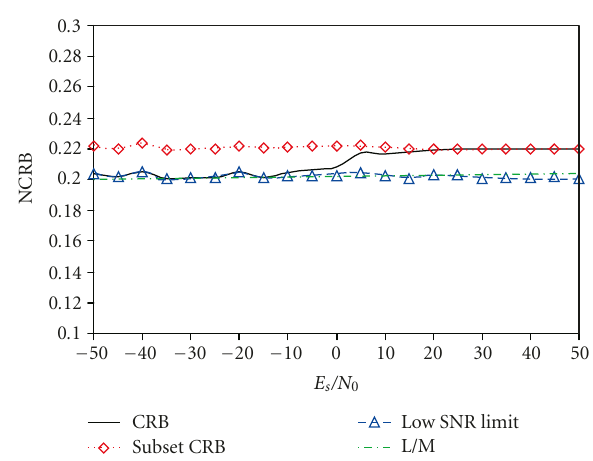
Figure 2: Normalized GCRB, ν = 7, N = 1024, M = 40.